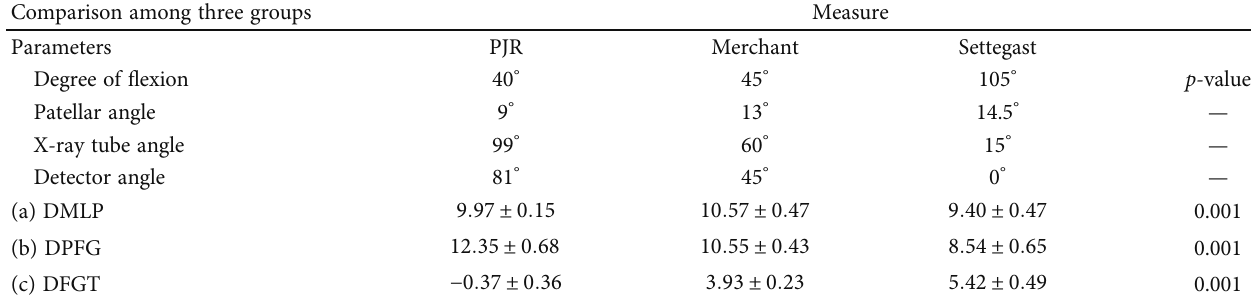
Table 3: Comparison of the measured values by PJR with those of the Merchant and Settegast methods. Comparison among three groups